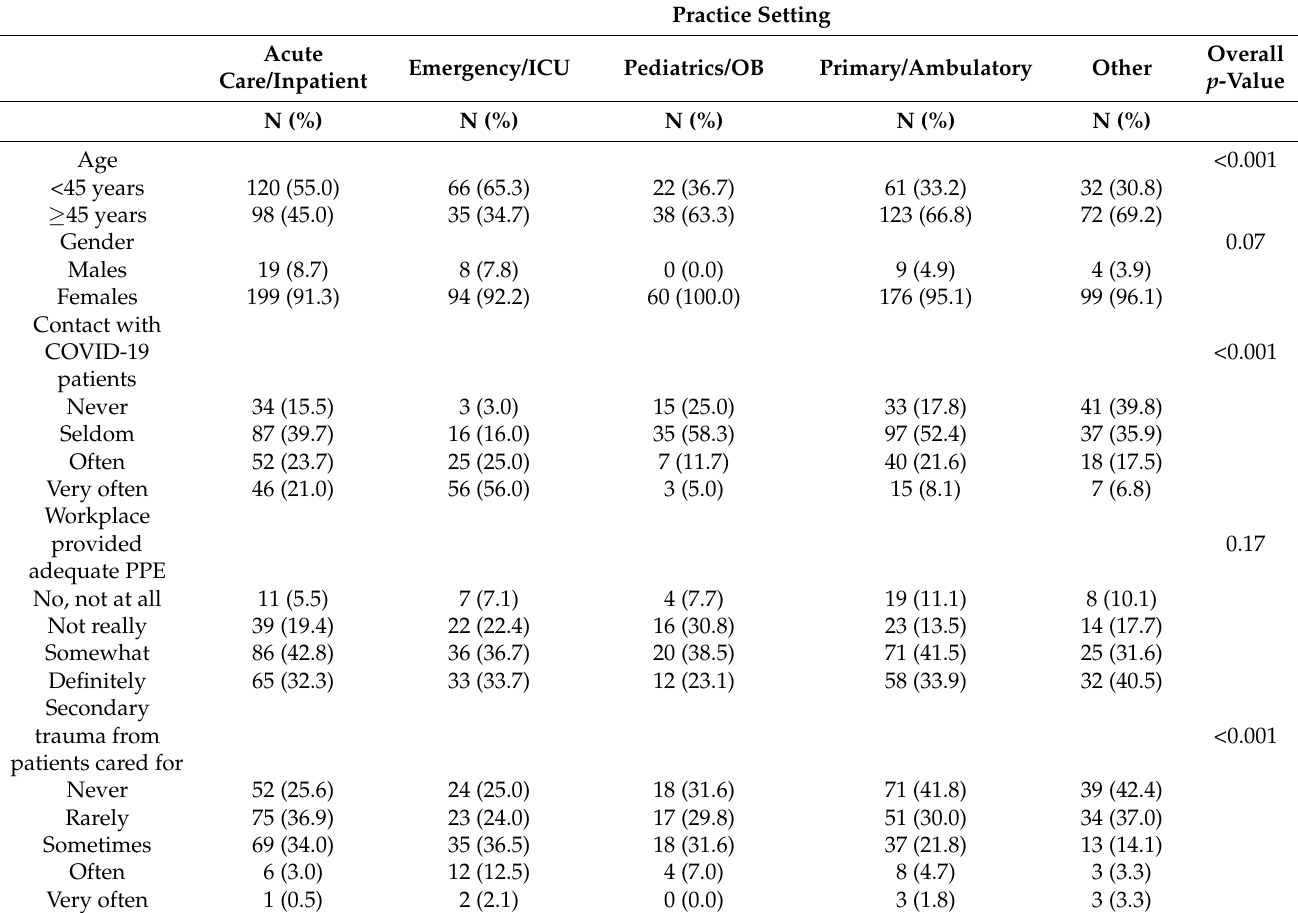
Table 2. Discrete study variables by practice setting (n = 695).